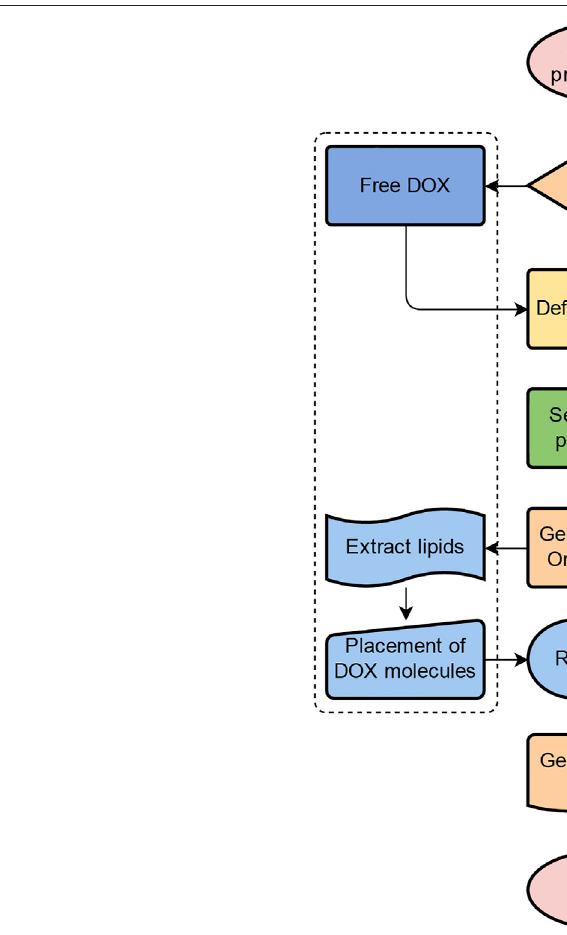
Frontiers in Bioengineering and Biotechnology |